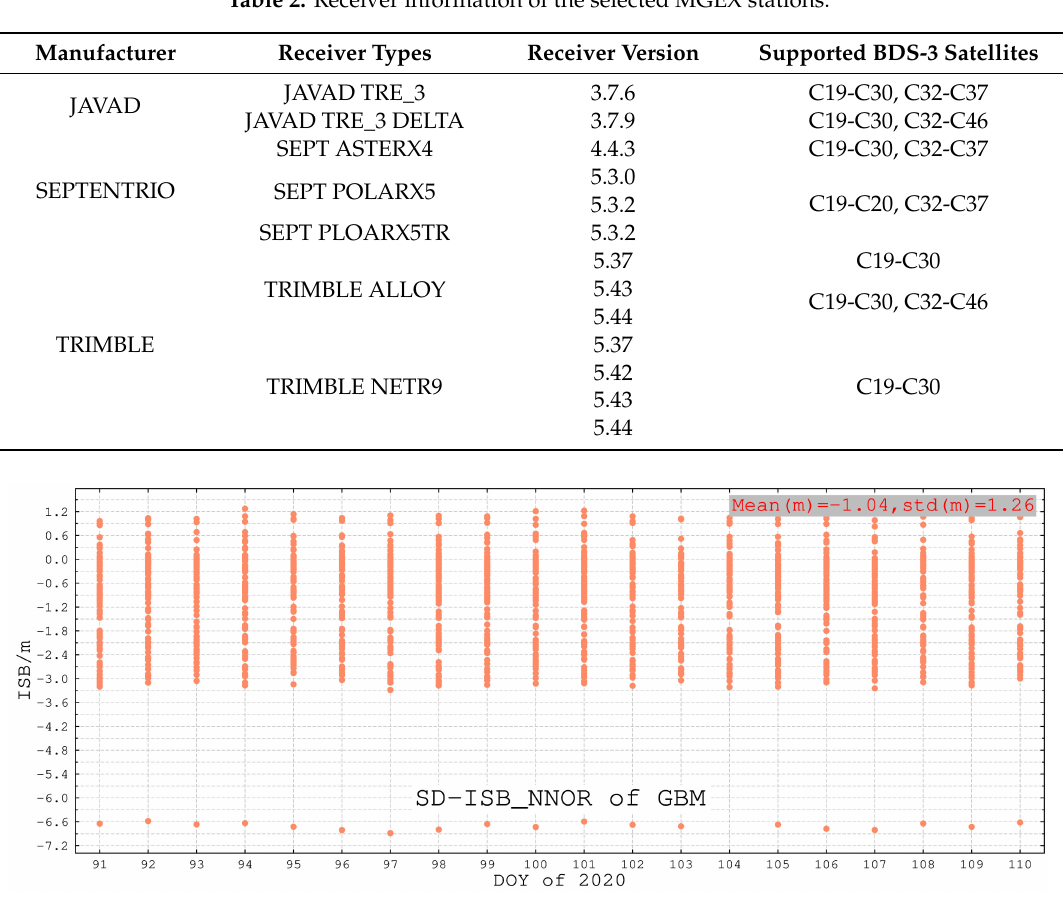
Figure 8. The single di ff erence ISB series of 85 stations by using GBM precise products from DOY 091 to 110, 2020. Reference station: